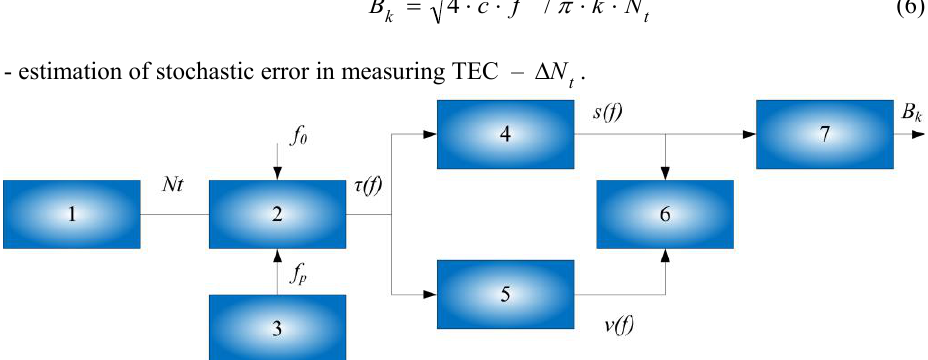
Fig. 1. Block scheme of the method for computing dispersion parameters and coherent bandwidth: 1 – TEC computation circuit; 2 – DC computation circuit; 3 – plasma frequency computation circuit; 4 – second-order dispersion parameter computation circuit; 5 - third-order dispersion parameter computation circuit; 6 - dispersion parameters plotting circuit; 7 - coherent bandwidth computation